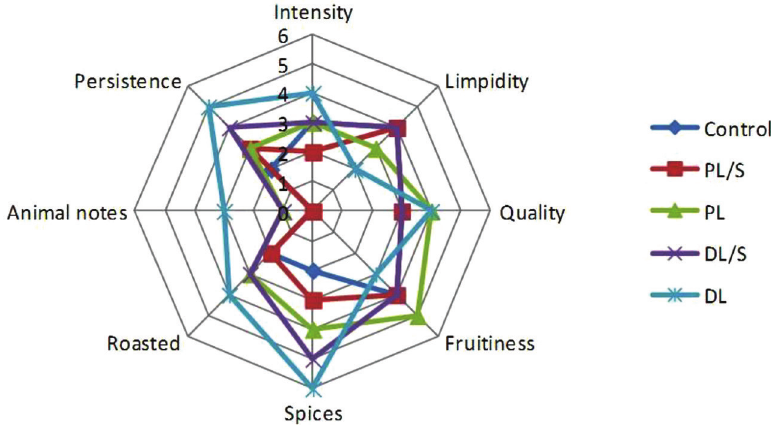
Fig. 5 – Aroma aspect of control sample: sulfurized wine in the first year of maturation (PL/S), unsulfurized wine in the first year of maturation (PL), sulfurized wine in the second year of maturation (DL/S), and unsulfurized wine in the first year of maturation (DL)